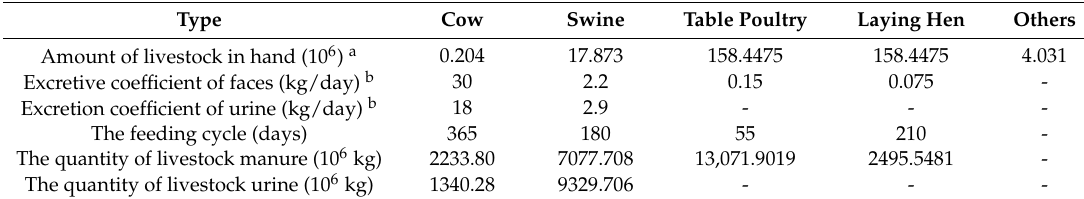
Table 4. The quantity of livestock wastes in 2014 in Jiangsu Province, China. Type Cow Swine Table Poultry Laying Hen